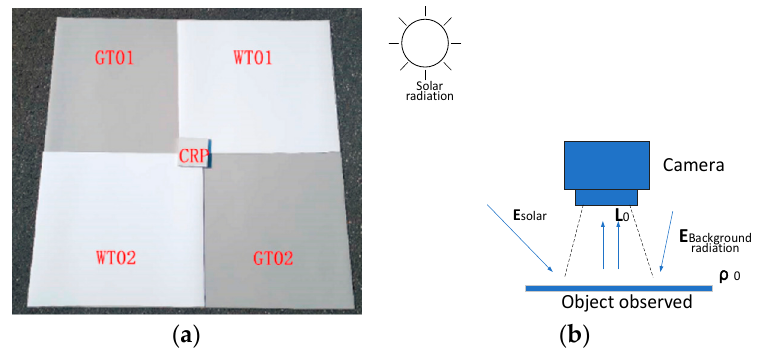
Figure 17. Verification experiments: ( a ) layout of observation targets; ( b ) schematic of the experimentalsetup.